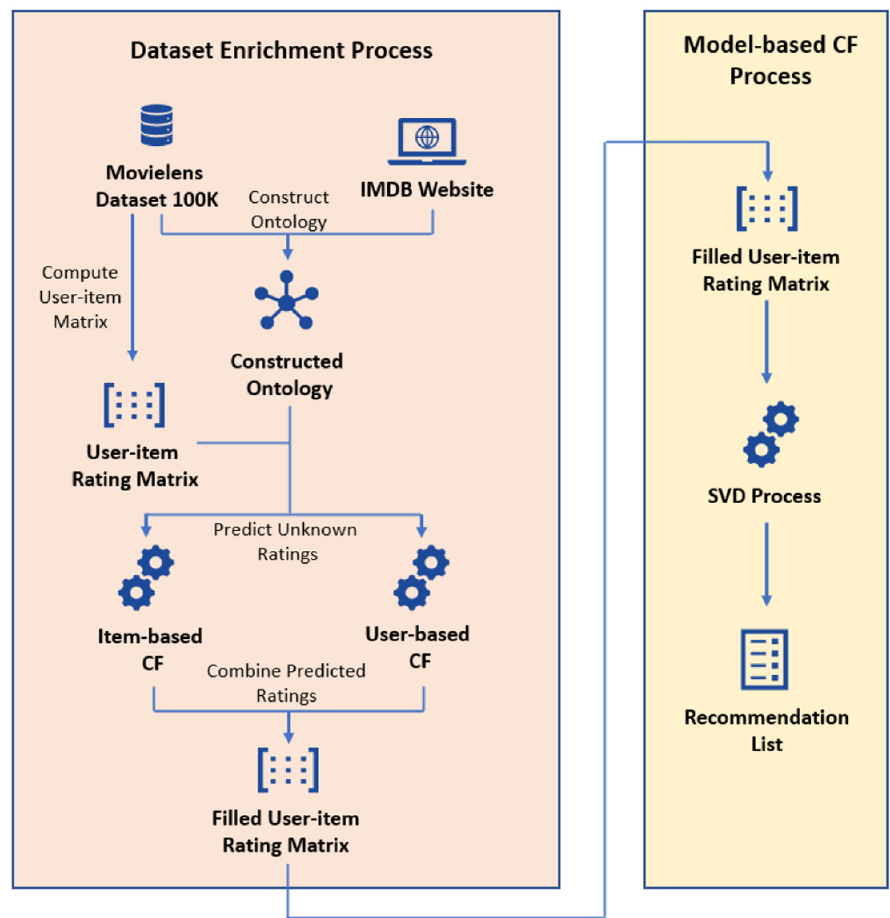
Figure 1. Flow diagram of the proposed